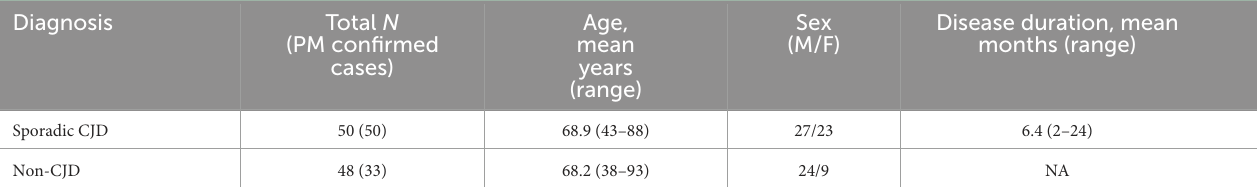
TABLE 1 Basic demographics of the study